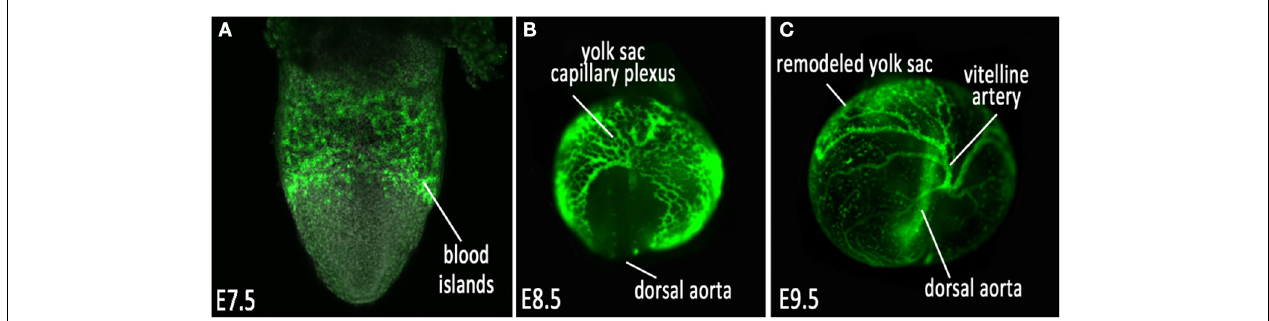
FIGURE 1 | Vascular development of the mouse embryonic yolk sac. (A) VEGFR2/Flk1 expression labeling nascent vessels in the blood islands at E7.5; (B) ε -globin-GFP labeled erythroblasts filling the primitive capillary plexus at E8.5, and (C) after vascular remodeling at E9.5.